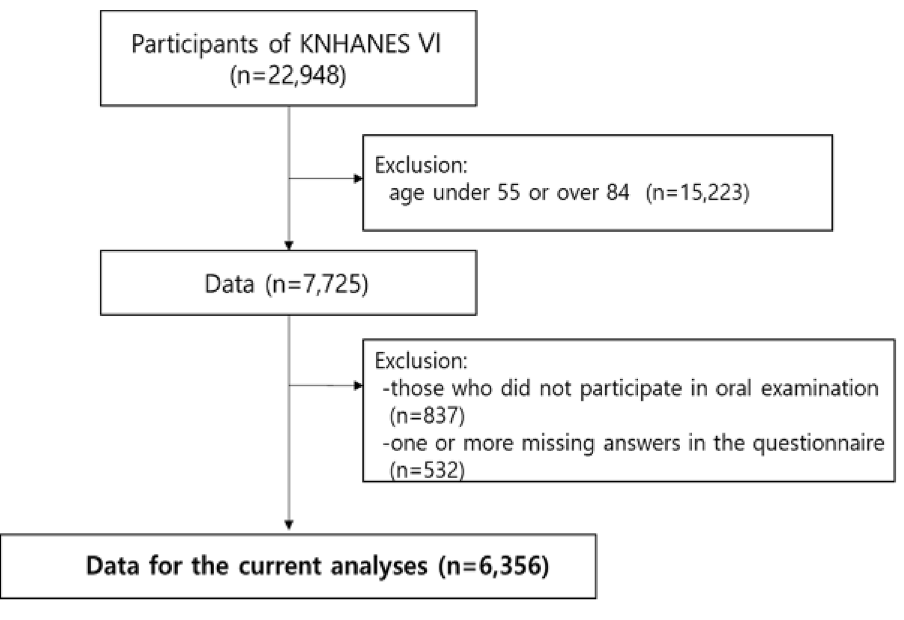
Figure 1. Flow chart of study